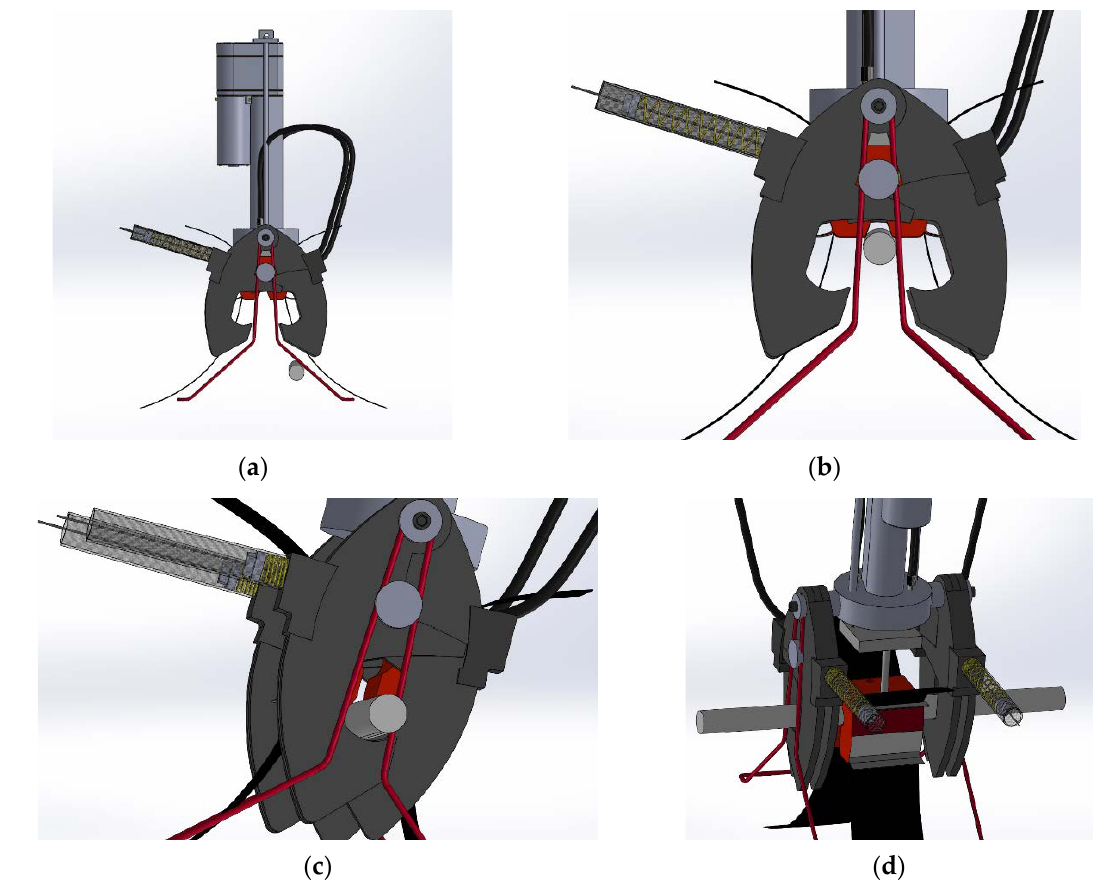
Figure 7. ( a ) Automatic installation process. The aerial robot carries the installation tool with a pre-charged diverter and approaches the power line cable. ( b ) The cable is centered in the tool while the aerial robot descends. ( c ) When the cable is in place, the linear actuator closes the clamps and pushes the diverter on the cable. ( d ) Finally, the linear actuator retracts, detaching the diverter and opening the clamps before flying out.